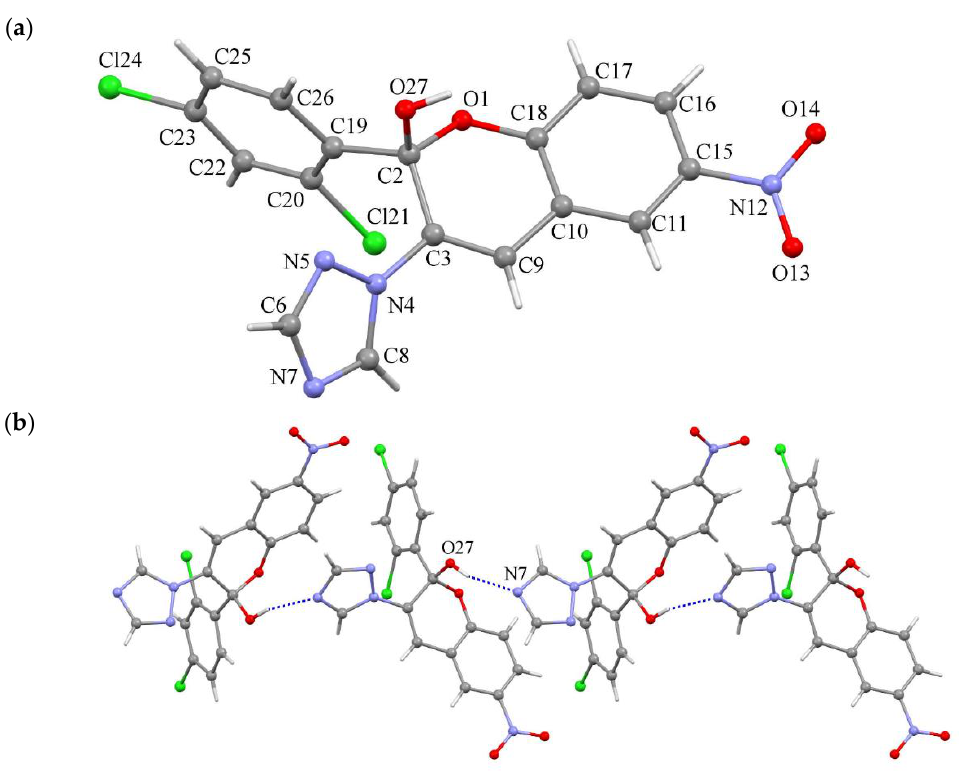
Figure 4. Molecular structure of 3 h determined by single-crystal X-ray diffraction method ( a ), a fragment of crystal packing in structure 3 h illustrates the formation of intermolecular hydrogen bonds O27 –H… N7, which bind 3 h molecules into a chain ( b ).